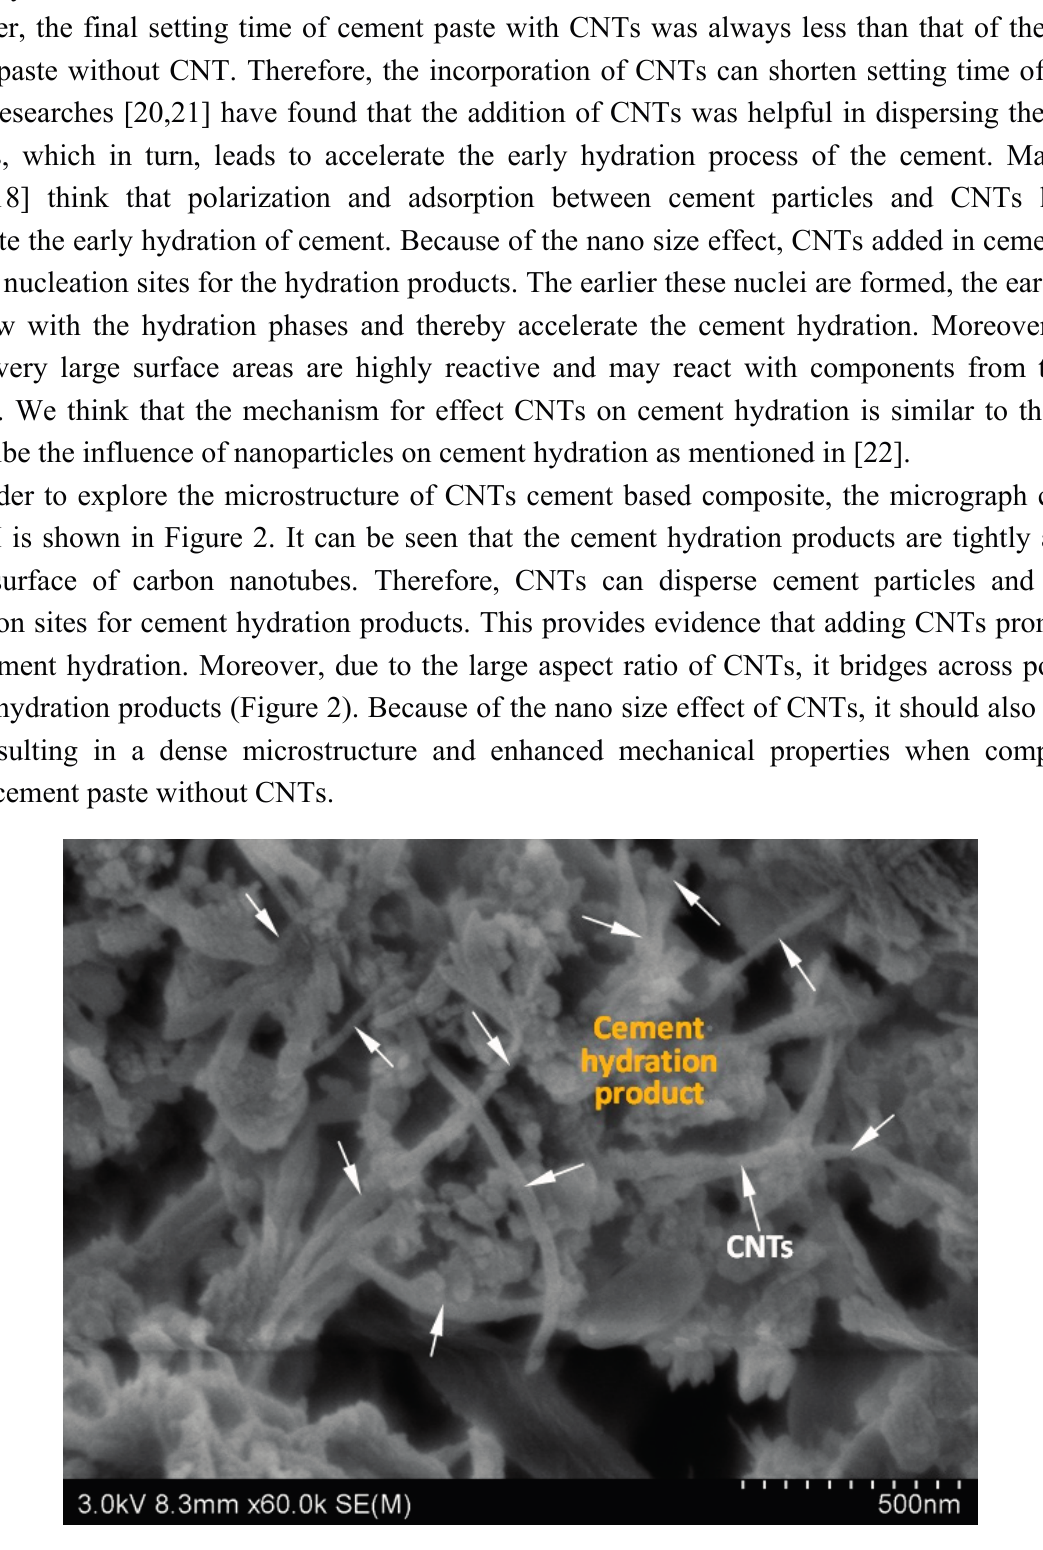
Figure 2. Microstructure of MPCM-CP with 0.25% CNTs (cement hydrated 12